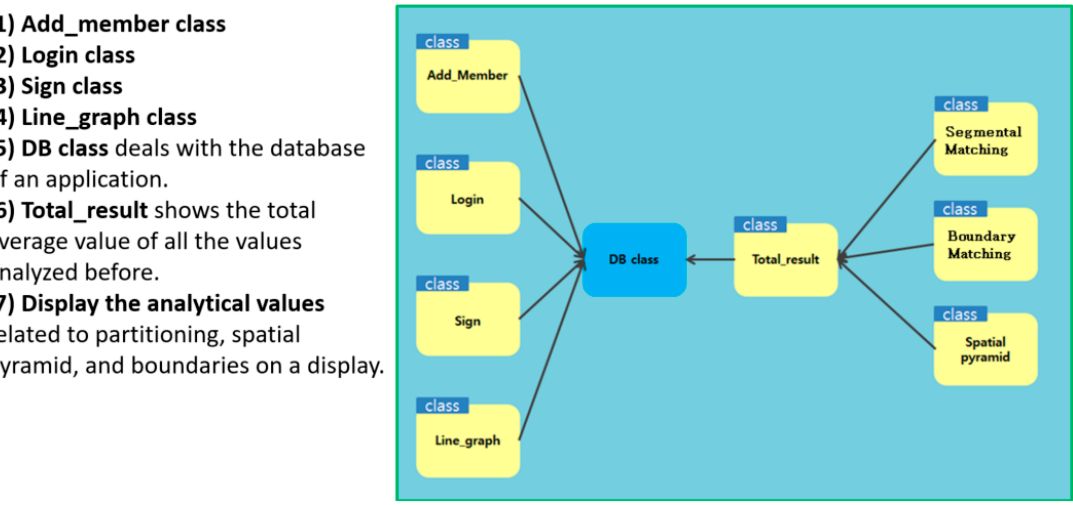
Figure 5. Entire unified modeling language.